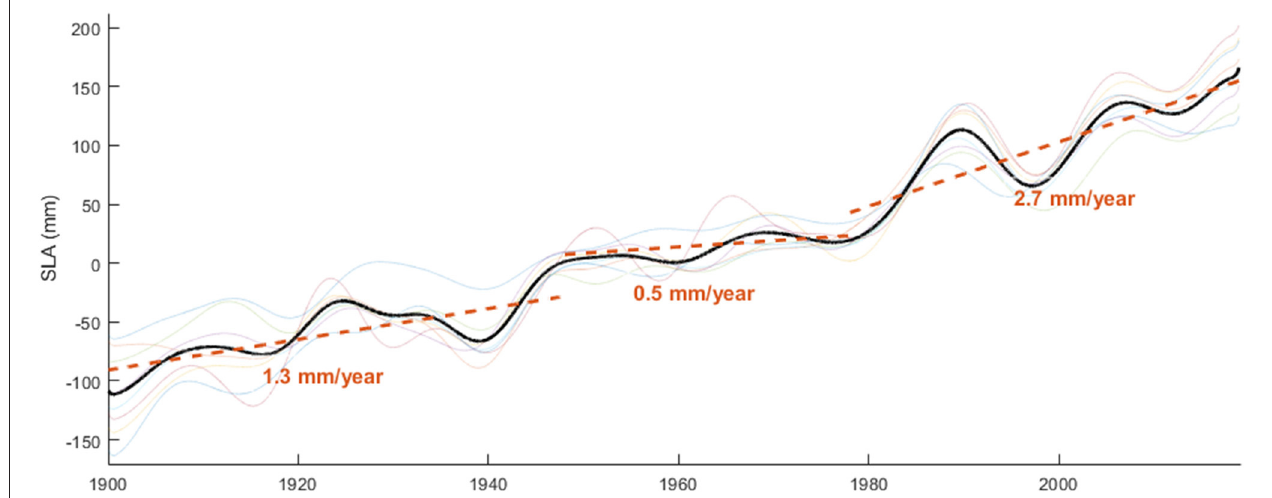
FIGURE 5 | Sea level variation in the tide gauge stations after applying a low-pass filter to remove the decadal or shorter variations. The transparent curves demonstrate the variation of individual tide gauges and the black curve is the mean for all stations. The orange dashed lines represent the trend fitted to the monthly mean of the tide gauges (not the filtered). The global hiatus in sea level rise (the 1950–1970s) is evident in the sea level rise of the basin.